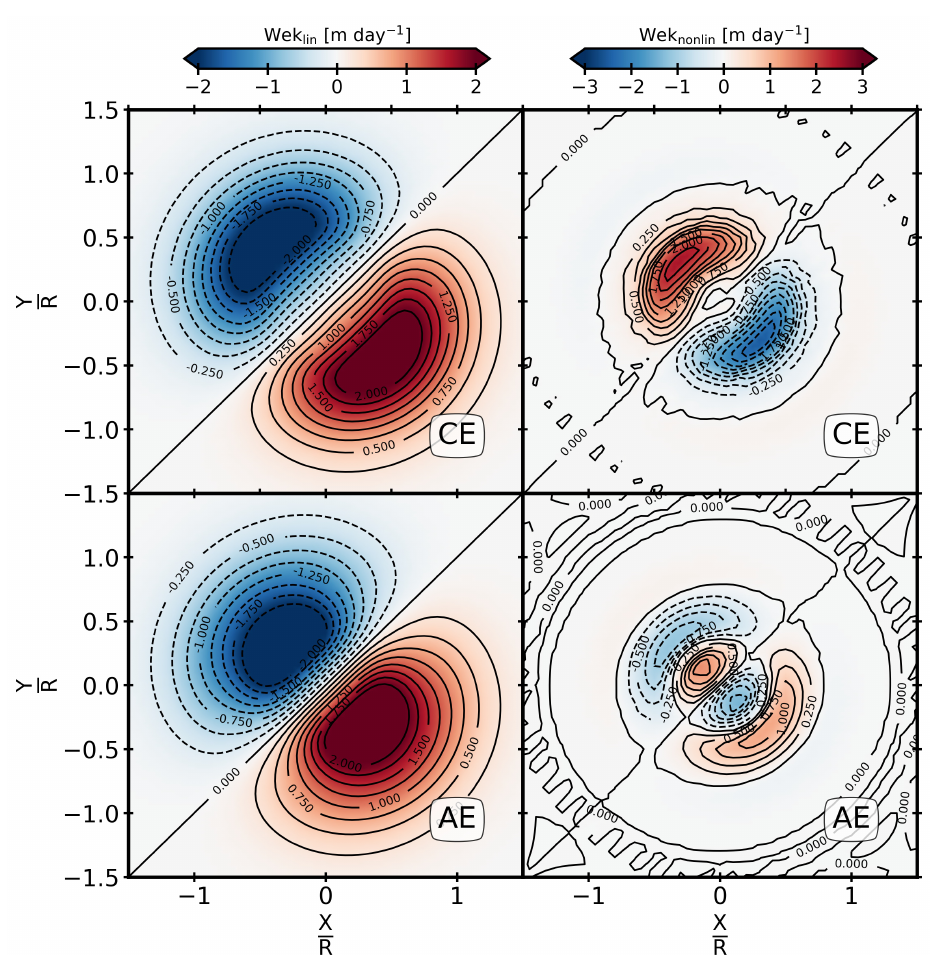
Figure 16. The vertical pumping velocity due to the linear and nonlinear Ekman components during the northeastern monsoon.